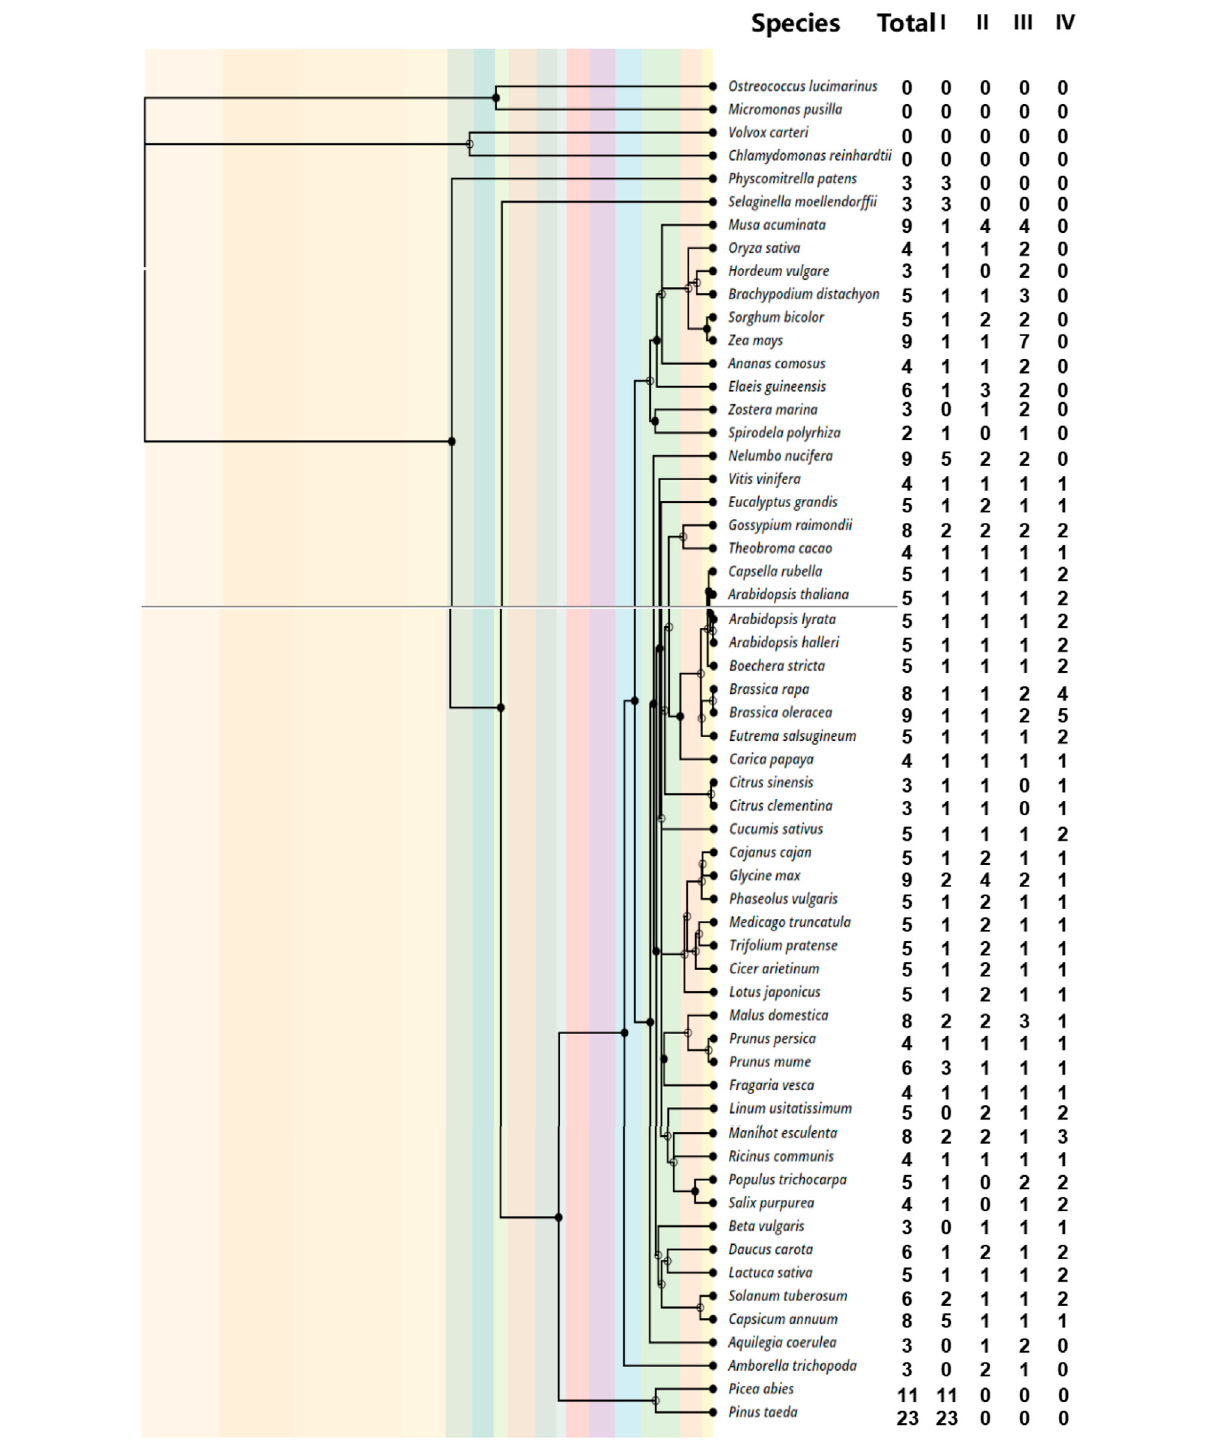
Frontiers in Genetics |